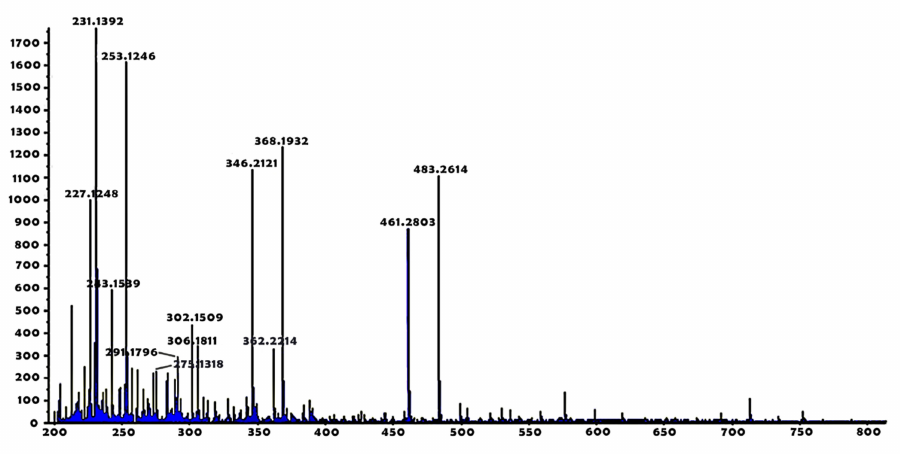
Figure 1. MALDI-TOF MS spectrum of antioxidant peptides isolated from the water extract of